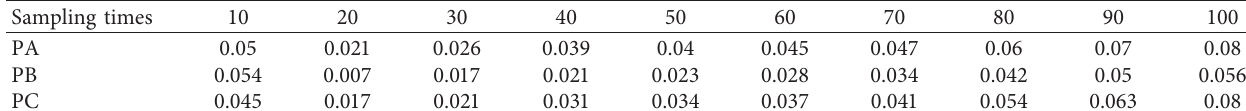
Table 5: The relationship between algorithm RANSAC sampling times and running time.